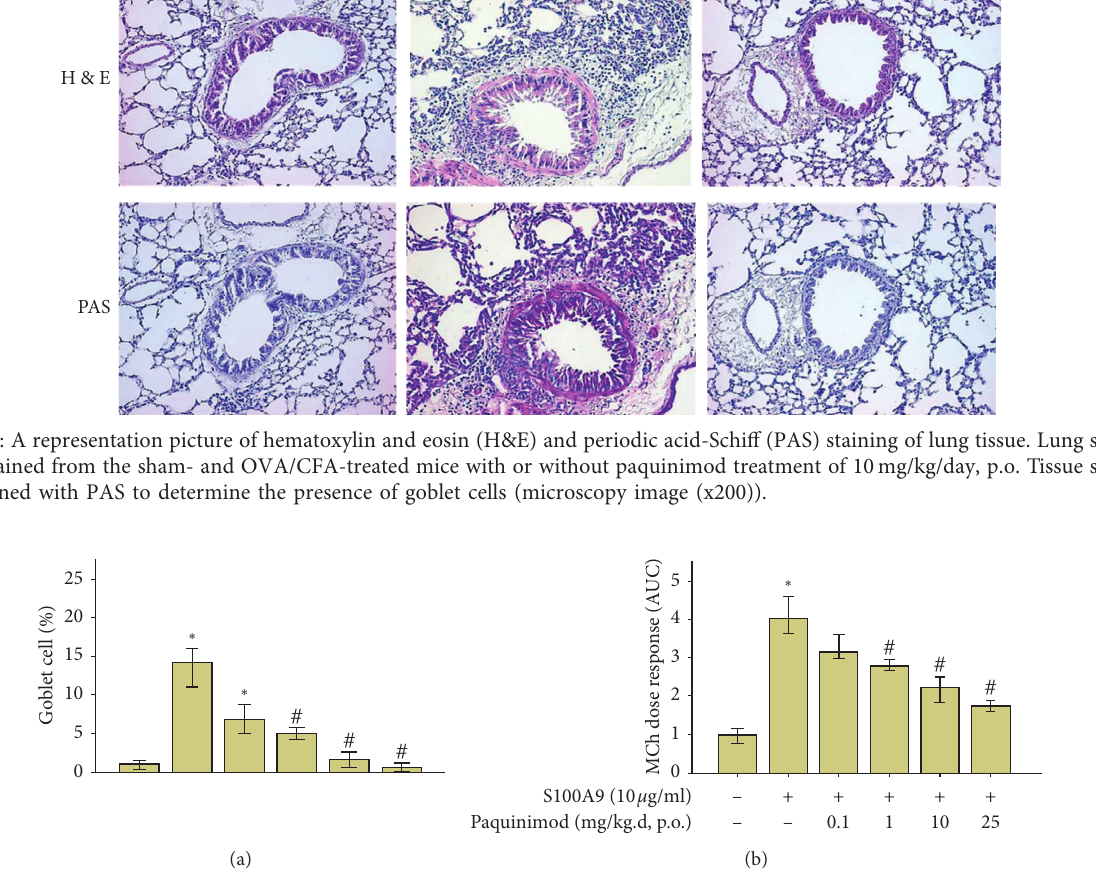
Figure 3: Effect of paquinimod on goblet cell count and lung resistance of OVA/CFA-treated mice. (a) Percentage of goblet cells in bronchial epithelium; periodic acid-Schiff (PAS)-positive cells and total epithelial cells were counted in the epithelium and the percentage of PAS-positive cells was calculated ( n � 8 in each group). (b) Lung resistance of sham-treated or OVA/CFA-treated mice and OVA/CFA plus paquinimod (0.1mg/kg/day to 25mg/kg/day, p.o.) after challenges with increasing concentrations of methacholine ( n � 8 in each group). ∗ P < 0 . 05 compared with the sham group; # P < 0 . 05 compared with the OVA/CFA group. The P value was obtained using the Man- n–Whitney U